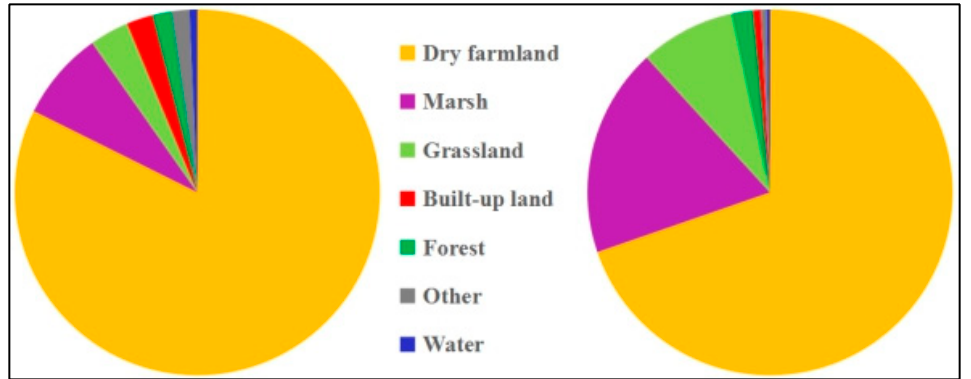
Figure 9. Area contribution of transformation between paddy field and other LULC types from 1954 to 2015. ( Left ) Transformation from paddy field to other LULC types; ( right ) transformation from other LULC types to paddy field.